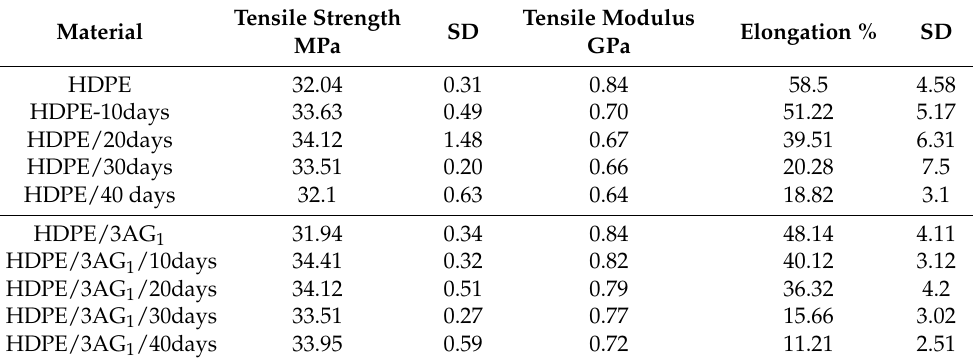
Table 3. Tensile strength, tensile modulus, and elongation data on HDPE and HDPE/3AG 1 compos- ites on